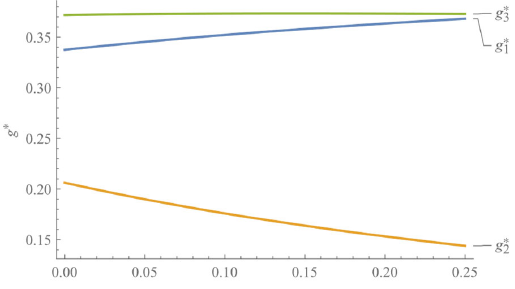
retailers’ service innovation